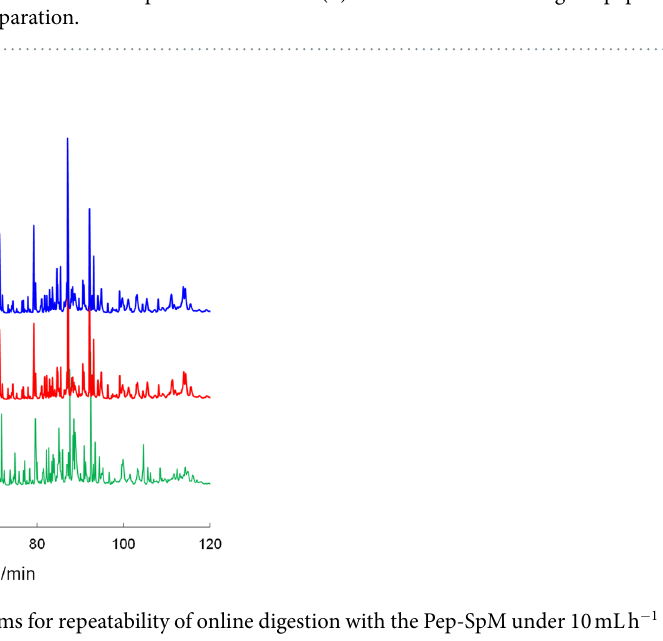
Figure 7. Detected peptides by the online digestion of an antibody by the Pep-SpM. ( a ) The number of the assigned peptides against the number of the composed amino acids. ( b ) The number of the assigned peptides against the elution time in LC separation.